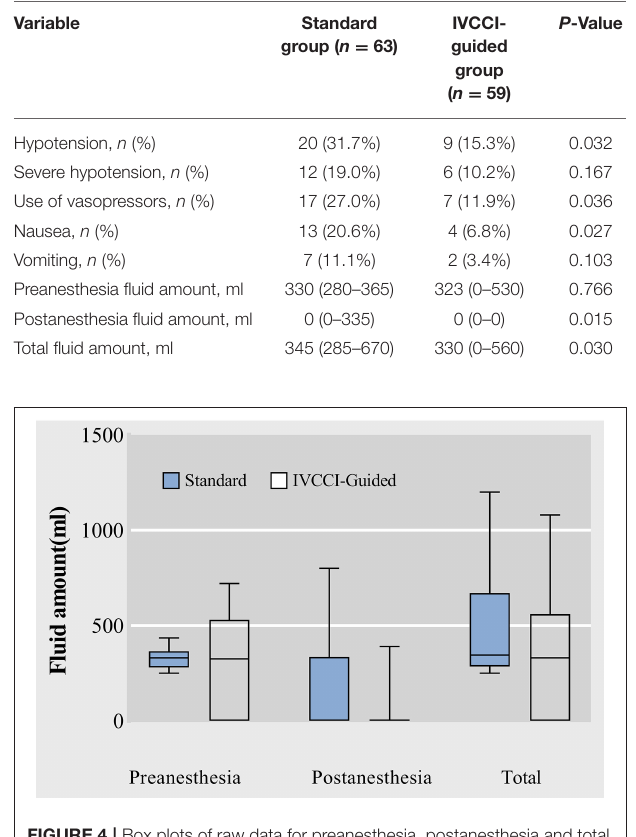
FIGURE 4 | Box plots of raw data for preanesthesia, postanesthesia and total fluid amount administrated. Data are median (central line) and interquartile range (box